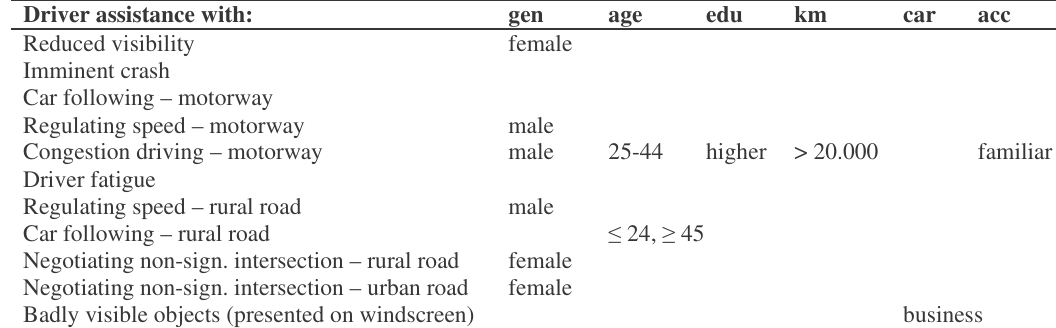
Table 8. Positive relationships between driver characteristics and driver assistance Driver assistance